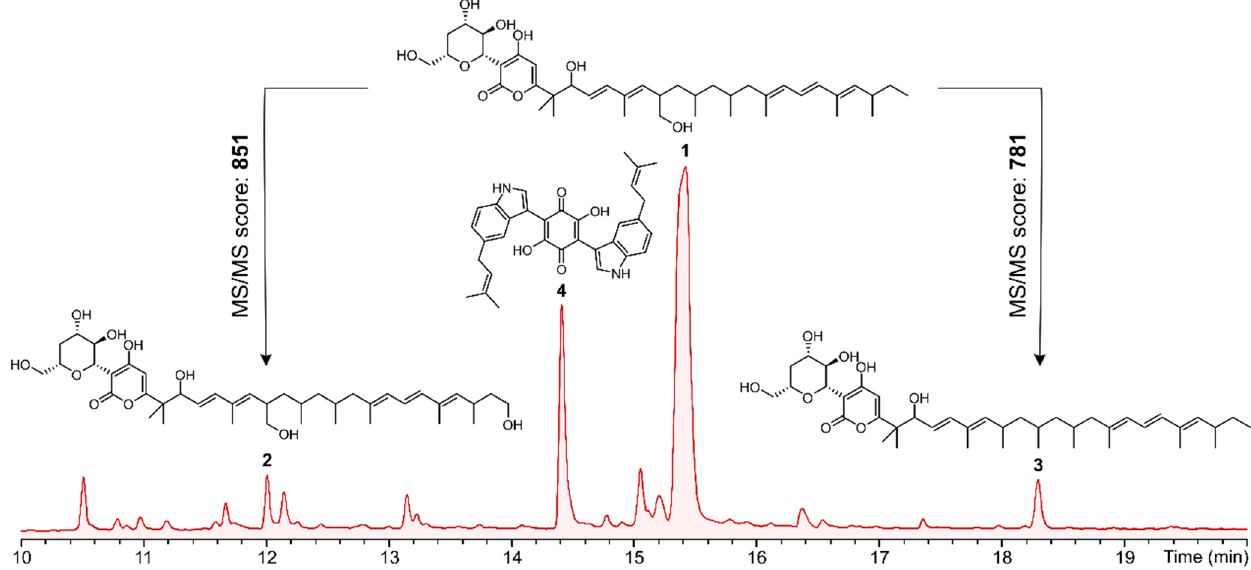
Figure 4. HPLC-UV/Vis chromatogram (210 nm) of the crude extract from the rice culture of A. hispanica sp. nov. with peaks of isolated compounds indicated by bold numbers referring to the depicted molecules ( 1 – 4 ). Over the arrows, the MS/MS similarity scores between MS/MS spectra from compounds 2 and 3 and the MS/MS spectrum of 1 are shown. Complete HPLC-UV/Vis chro- matogram (210 nm) from 0 to 25 min is shown in Figure S20. In this way, compound 2 was obtained as a colorless amorphous powder. The molec- ular ion cluster at m / z 717.45596 [M + H] + in the HRESI-MS spectrum indicated that the